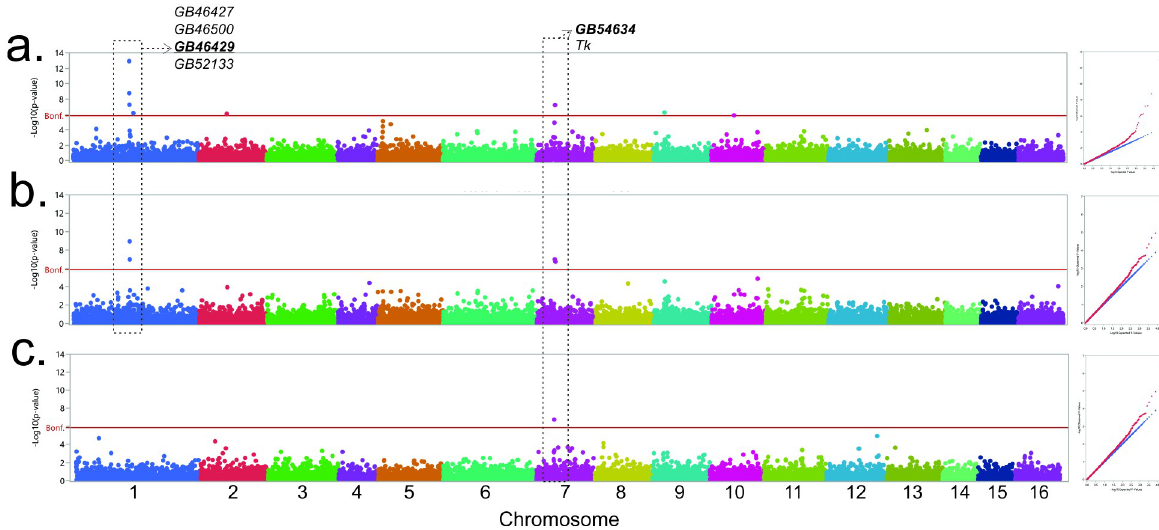
Fig 1. Manhattan and QQ plots of the respective genome wide association study for a. tergite color ranked-transformed; b. scutellar plate color ranked-transformed; and c. ovariole number rank-transformed. Respective annotated genes within the shared regions in chromosomes LG1 and LG7, as well as genes possessing non-synonymous variants (in bold), are also shown. The red line represents the Bonferroni corrected threshold value of P � 4.28 x 10 − 6 , and markers above this line are significantly correlated to the respective trait.